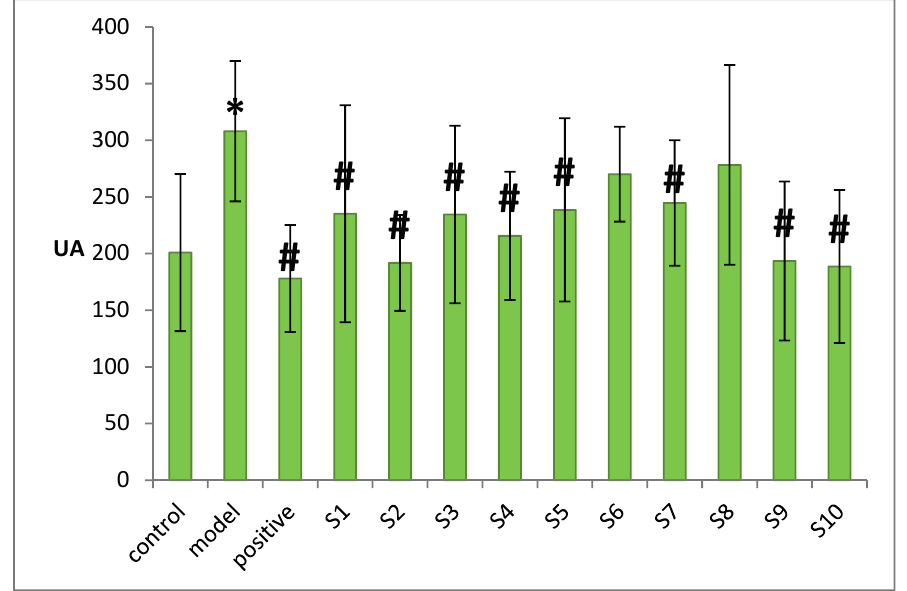
Figure 4. Results of UA-lowering activities. The rates of UA-lowering for 13 groups were presented as mean ± SD ( n = 10) and the data were statistically evaluated by one-way ANOVA. p < 0.05 was considered statistically significant (compared with the control group * p < 0.05, compared with the model group # p <